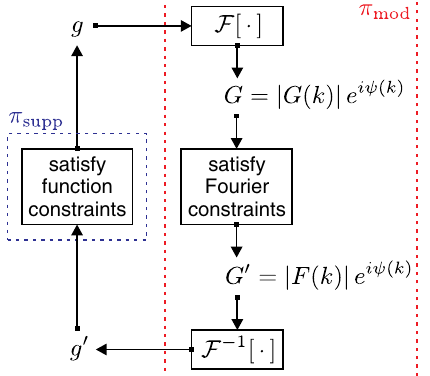
FIG. 1. Outline of the Gerchberg-Saxton phase-retrieval algo- rithm. For further details on each step see the text. Dashed boxes indicate the steps that form projections of a candidate function onto the support constraints, (cid:2) supp , and the Fourier-space modu- lus constraints, (cid:2) mod ,